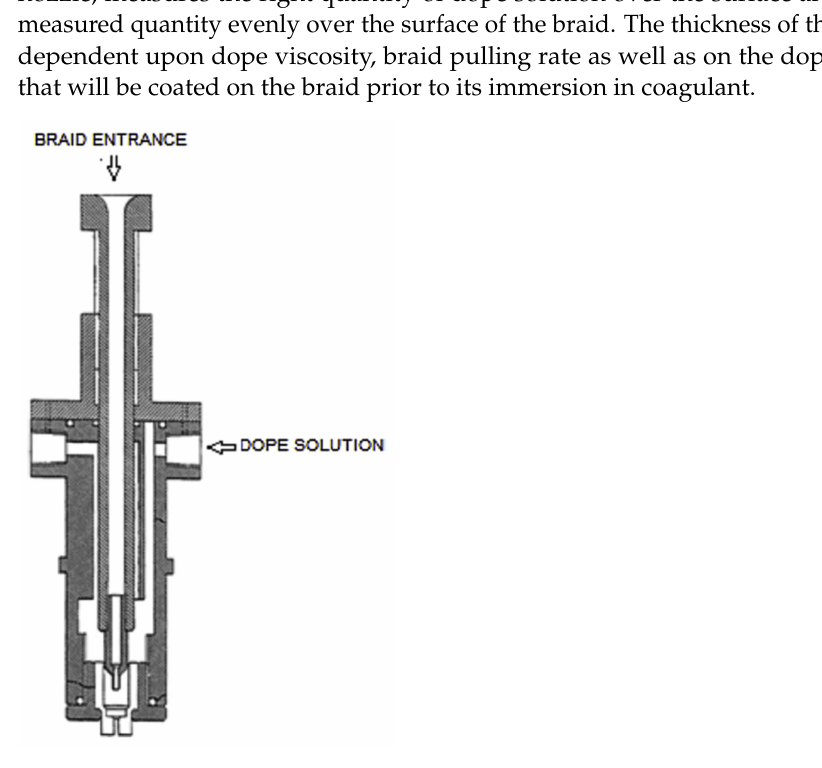
Figure 20. Nozzle design for production of BRHF membrane [15]. Reprinted/adapted with permis- sion from Ref. [15]. Copyright 2022,